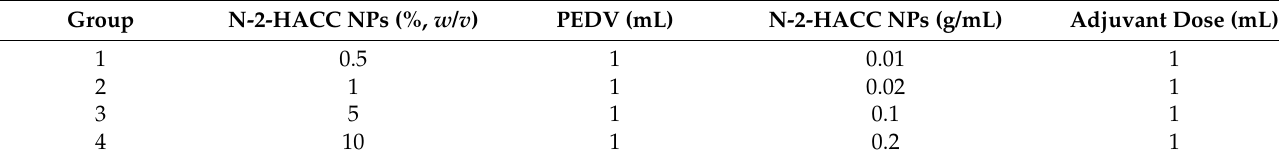
Table 1. The vaccine composition with different adjuvant